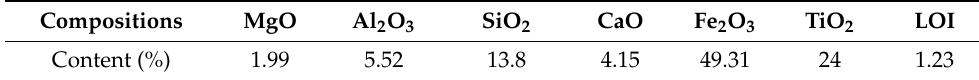
Table 2. Chemical composition of magnetite fine aggregate.